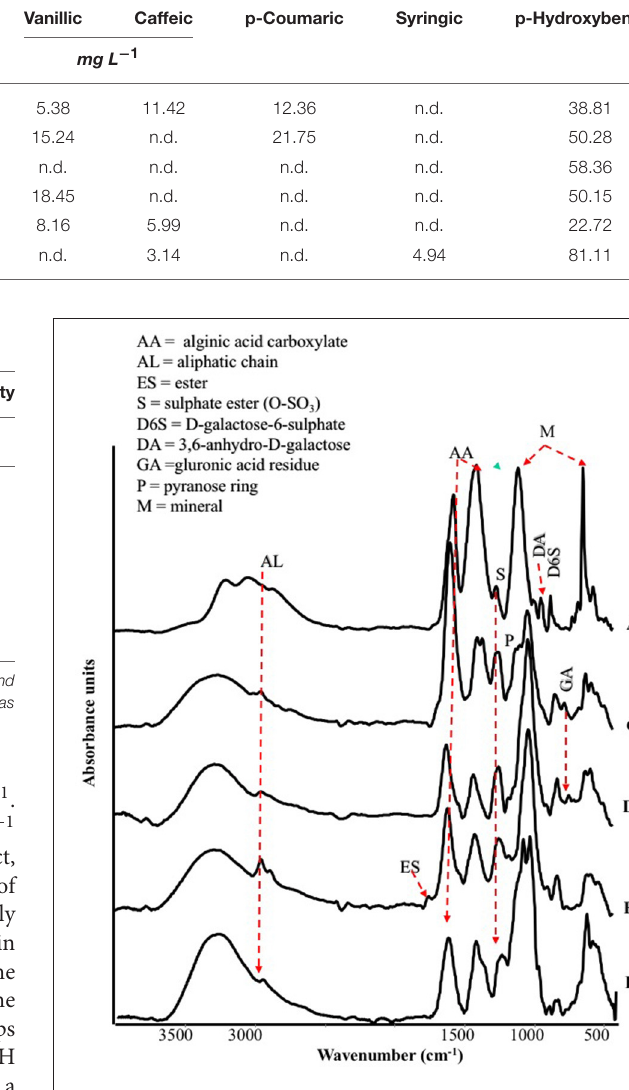
was characteristic of glucuronic acid residues. Going into more details, E extract was also characterized by a high content in lipids, as revealed by two sets of strong C-H vibration at 2,930 cm − 1 and 2,854 cm − 1 , which are the most intense in the spectra depicted in Figure 1 , and the stretching vibration of carboxylic ester groups, evidenced by the band pinpointed at 1,734 cm − 1 (Leal et al., 2008). Finally, the shoulder at 1,510 cm − 1 was typical of aromatic rings vibration, consistently with the highest content of gallic and protocatechuic acids determined in E extract and of p-hydroxybenzoic acid in F extract ( Table 2